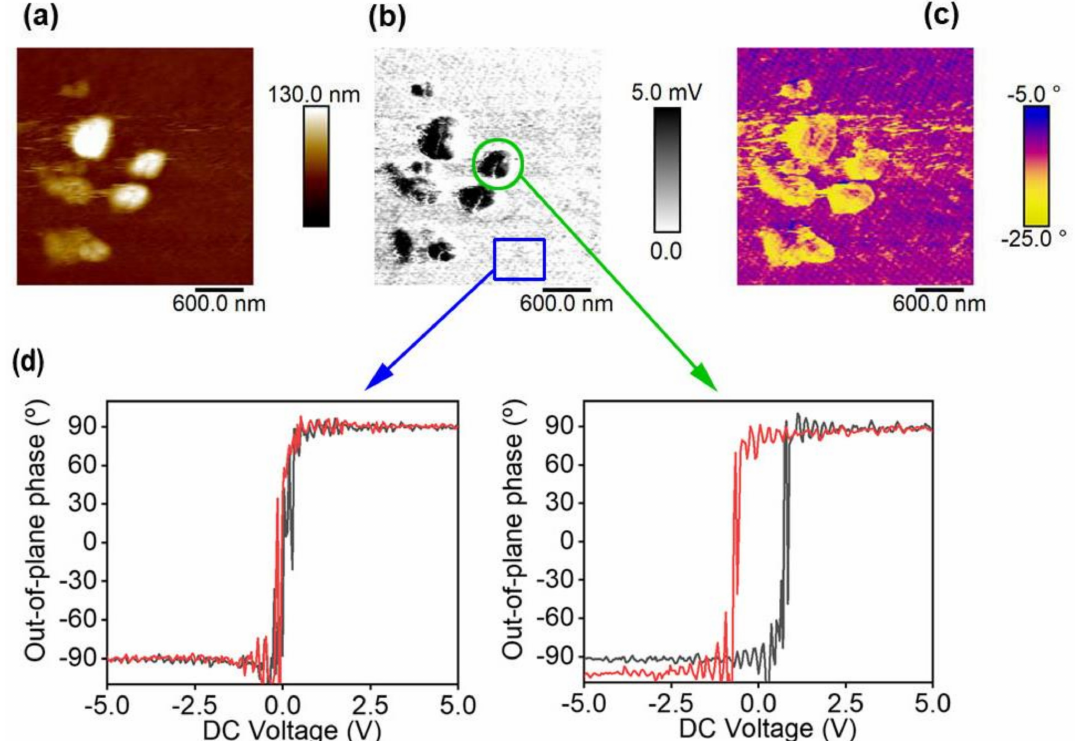
Figure 8. ( a ) Topography image in contact mode of PEDOT/PSS/(P(VDF-TrFE) nanoparticles; ( b ) piezoelectric amplitude; ( c ) piezoelectric phase in the out-of-plane direction; ( d ) piezoelectric phase in the out-of-plane direction measured applying a DC bias = − 5 V → 5 V → − 5 V over a flat zone associated with PEDOT/PSS film (blue square in ( b ) and on one of the protuberances associated with PVDF-TrFE nanoparticles embedded in the film (green circle in ( b